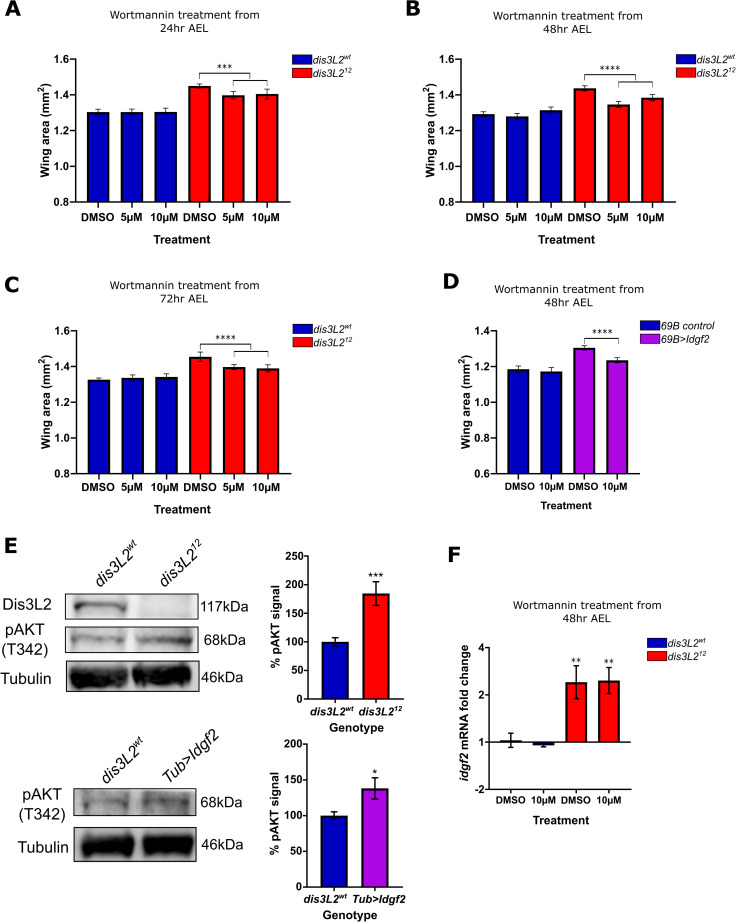
PI3-K is involved in driving proliferation in dis3L212 mutant wings.A-C) Feeding of Wortmannin to Drosophila larvae at 5μM or 10μM results in a significant reduction specifically in dis3L212 wings and not dis3L2wt wings. Developing larvae were cultured on Wortmannin or control (DMSO) containing food from (A) 24, (B) 48 or (C) 72 hours after egg lay (AEL). n = 16–58, error bars represent 95% CI, *** = p<0.001, **** = p<0.0001. D) Feeding of Wortmannin to larvae at 10μM results in a significant reduction of Idgf2 overexpression (69B>idgf2) wing area but not control (69B-GAL4 parental) wings. Developing larvae were cultured on Wortmannin or control (DMSO) containing food from 48 hours AEL. n = 20–33, error bars represent 95% CI, **** = p<0.0001. E) Assessment of AKT phosphorylation at T342 in dis3L2wt, dis3L212, and Idgf2 overexpression (driven by Tub-GAL4) 120hr old L3 larvae shows increased T342 phosphorylation in L3 larvae mutant for dis3L2 and those with ubiquitous Idgf2 overexpression. n = 6–10, error bars represent SEM, * = p = 0.0121, *** = p = 0.0003. F) Addition of 10μM Wortmannin does not affect idgf2 overexpression in dis3L212 wing imaginal discs showing Idgf2 is upstream of the Wortmannin sensitive pathway. n = 3–4, error bars represent SEM, ** = p<0.01.